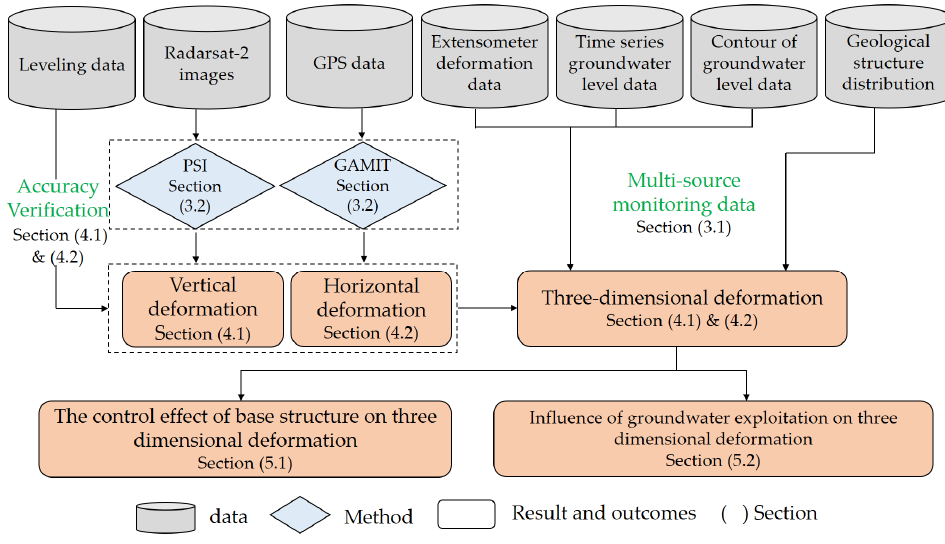
Figure 3. The flowchart of methodologies.